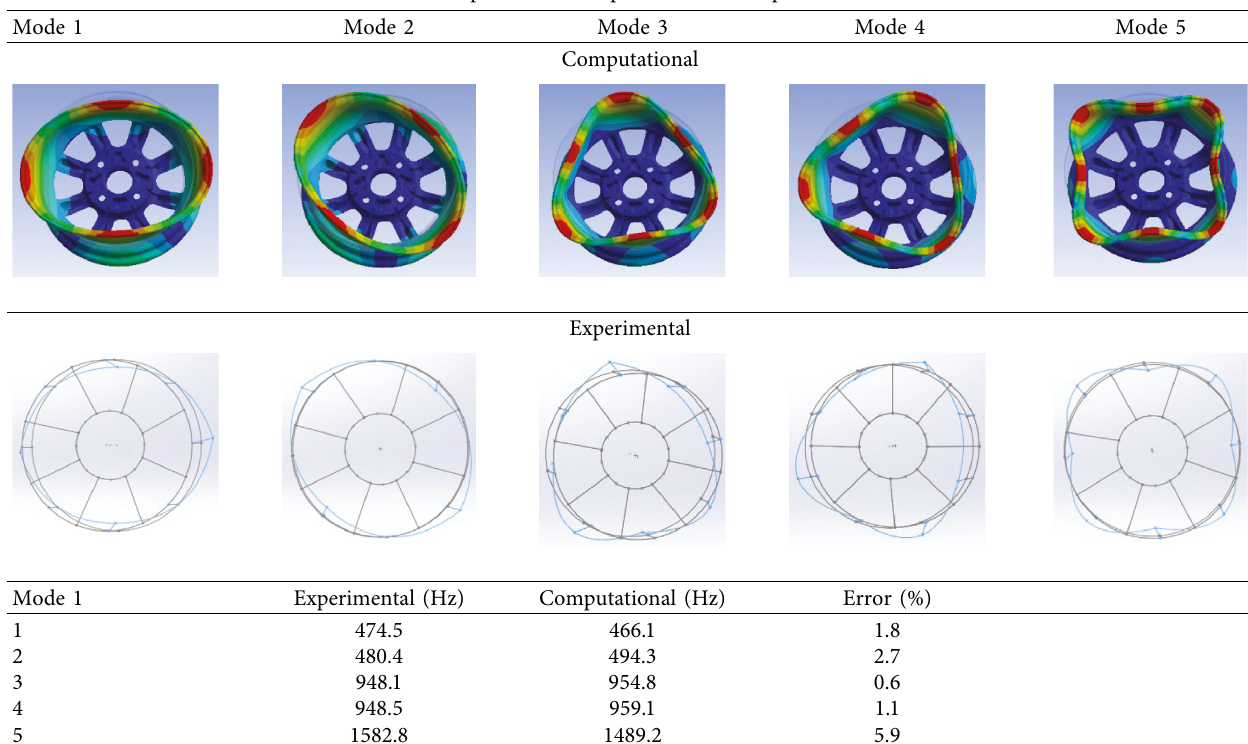
Figure 6: Wheel modal test. Table 2: Comparison of computational and experimental